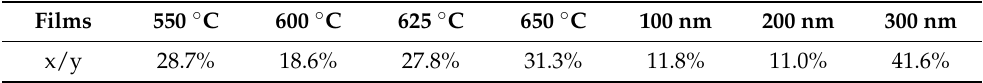
Table 1. The ratio of α -Fe to (Nd,Ce) 2 Fe 14 B in Ta/Nd-Ce-Fe-B/Ta films under different preparation